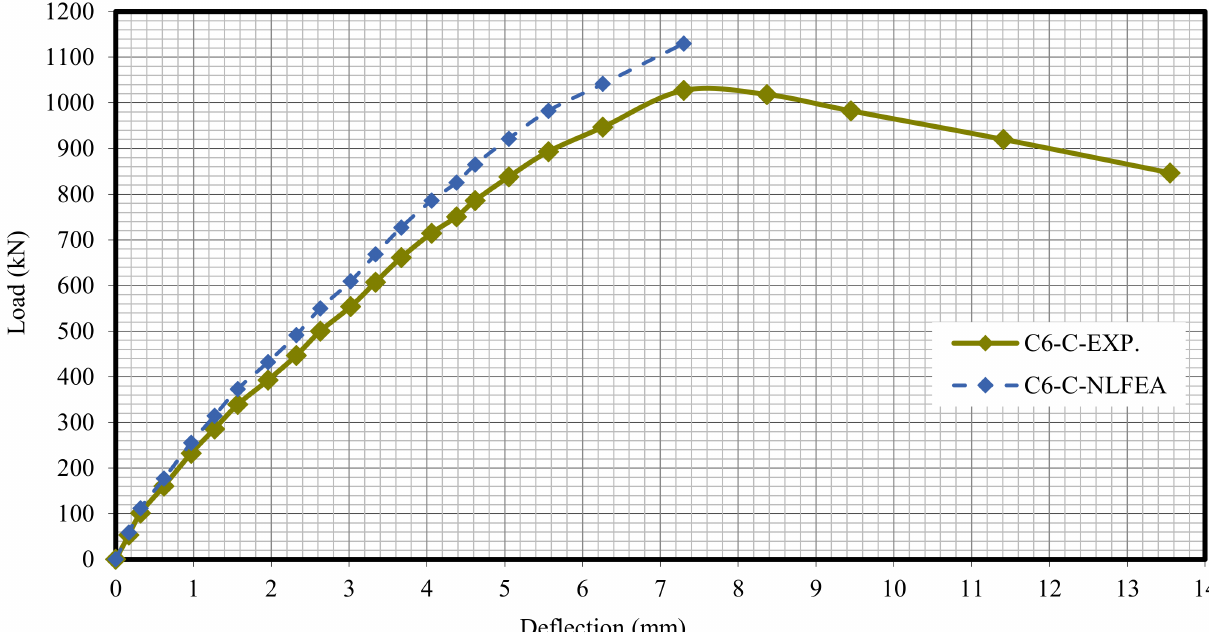
Figure 27. Load deflection of Column C6-C.